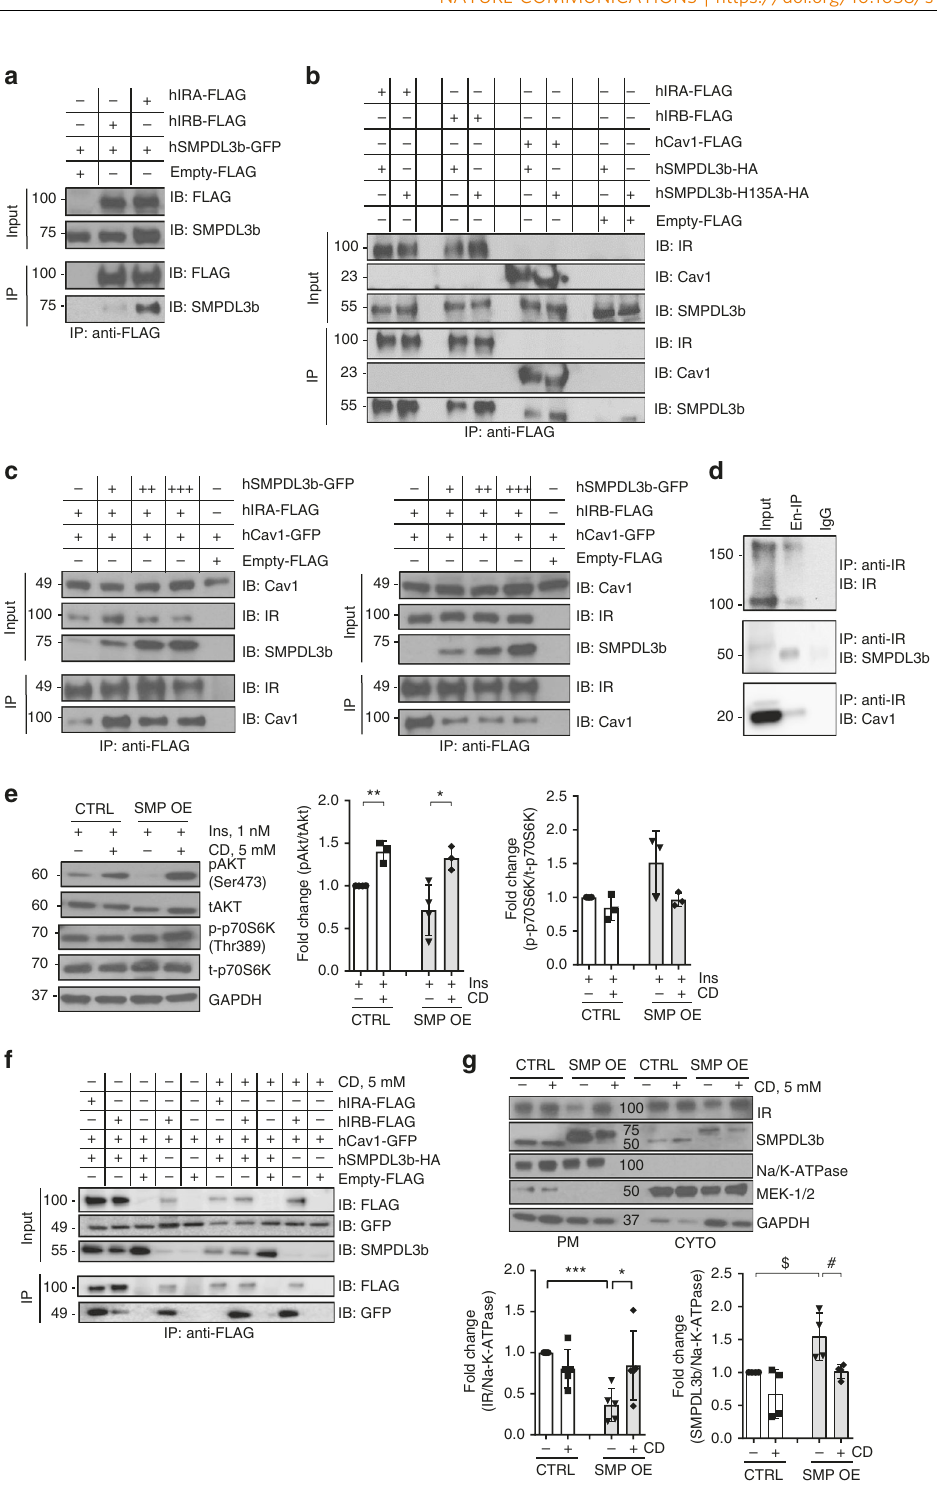
mice (Fig. 5i) with a tendency to a decreased foot processes width (Supplementary Fig. 4b). Immunohistochemistry analysis showed that fl / fl ;db/db glomeruli were characterized by increased phosphorylated AKT compared to + / + ;db/db mice (Fig. 5j). These results prompted us to further investigate the link between podocyte-speci fi c SMPDL3b de fi ciency, C1P availability and insulin signaling in the protection from